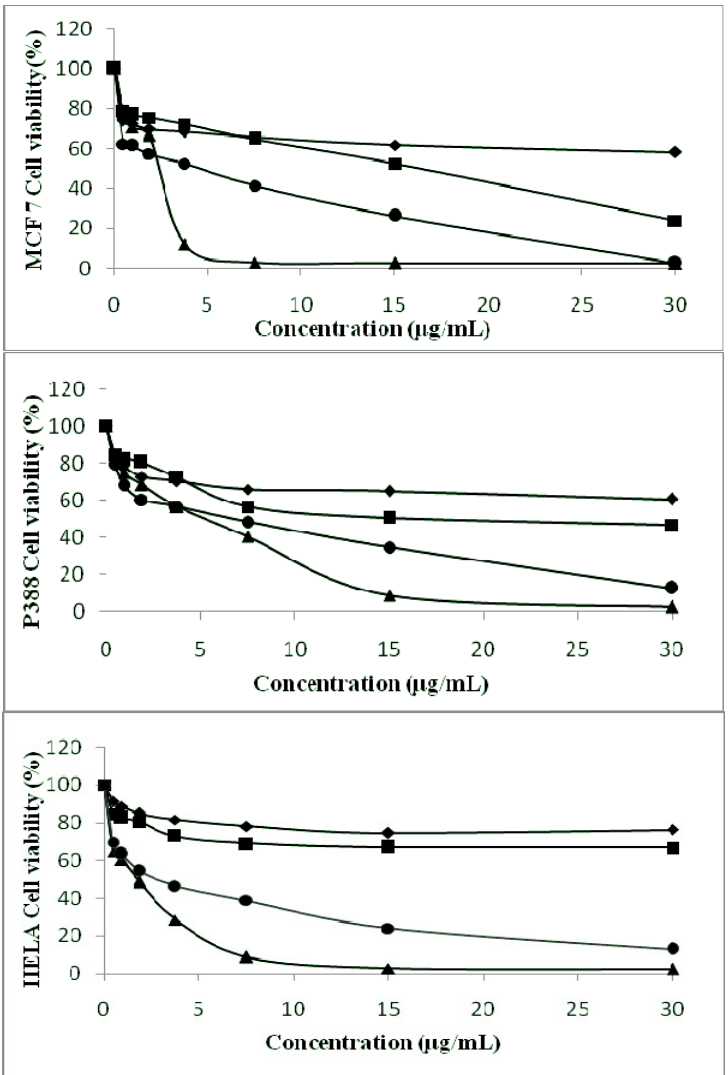
Figure 2. Effect of mahanine ( 1 ) ( ♦ ), mahanimbicine ( 2 ) ( ), essential oil (•) and mahanimbine ( 3 ) ( ▲ ) on the growth of MCF-7 cells, P388 cells and HELA cells according to concentration